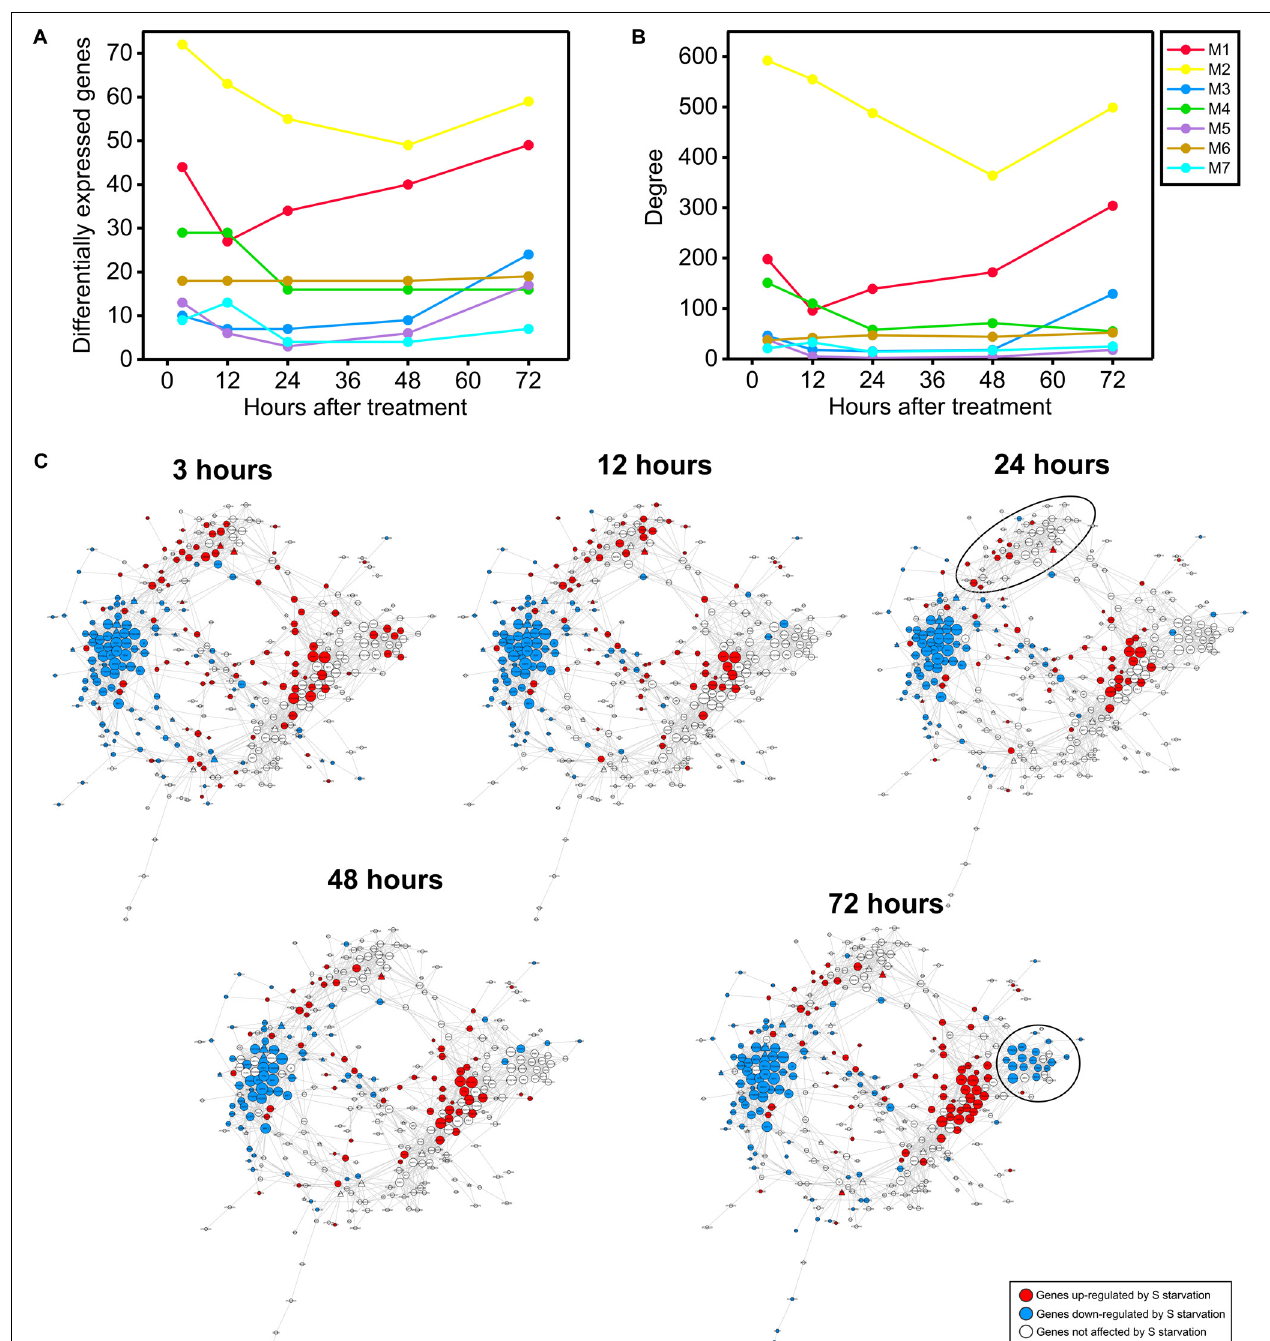
FIGURE 7 | Temporal dynamics of the sulfate co-expression network. (A) Temporal dynamics of the numbers of genes differentially expressed in response to sulfate starvation in a previous experiment (Iyer-Pascuzzi et al., 2011). The color code indicates the co-expression module to which each gene belongs according to the sulfate co-expression network presented in Figure 5 . (B) Temporal dynamics of the degree of each co-expression module according to the differentially expressed genes in the previously mentioned experiment (Iyer-Pascuzzi et al., 2011). The color code indicates the co-expression module. (C) Mapping of the differentially expressed genes in response to sulfate starvation at five different time points (3, 12, 24, 48, and 72 h). The red and blue colors indicate significant up- or down-regulation, respectively, in response to sulfate starvation (adjusted p -value < 0.05 and log 2 |FC| > 1 or < –1). The microarray data were obtained from the experiment GSE30098 of GEO (Iyer-Pascuzzi et al., 2011). The shape of each specific node is related to TFs (triangle) or targets (circle), the size depends on the number of connections of each node in such a way that nodes with higher size are the most connected genes in the